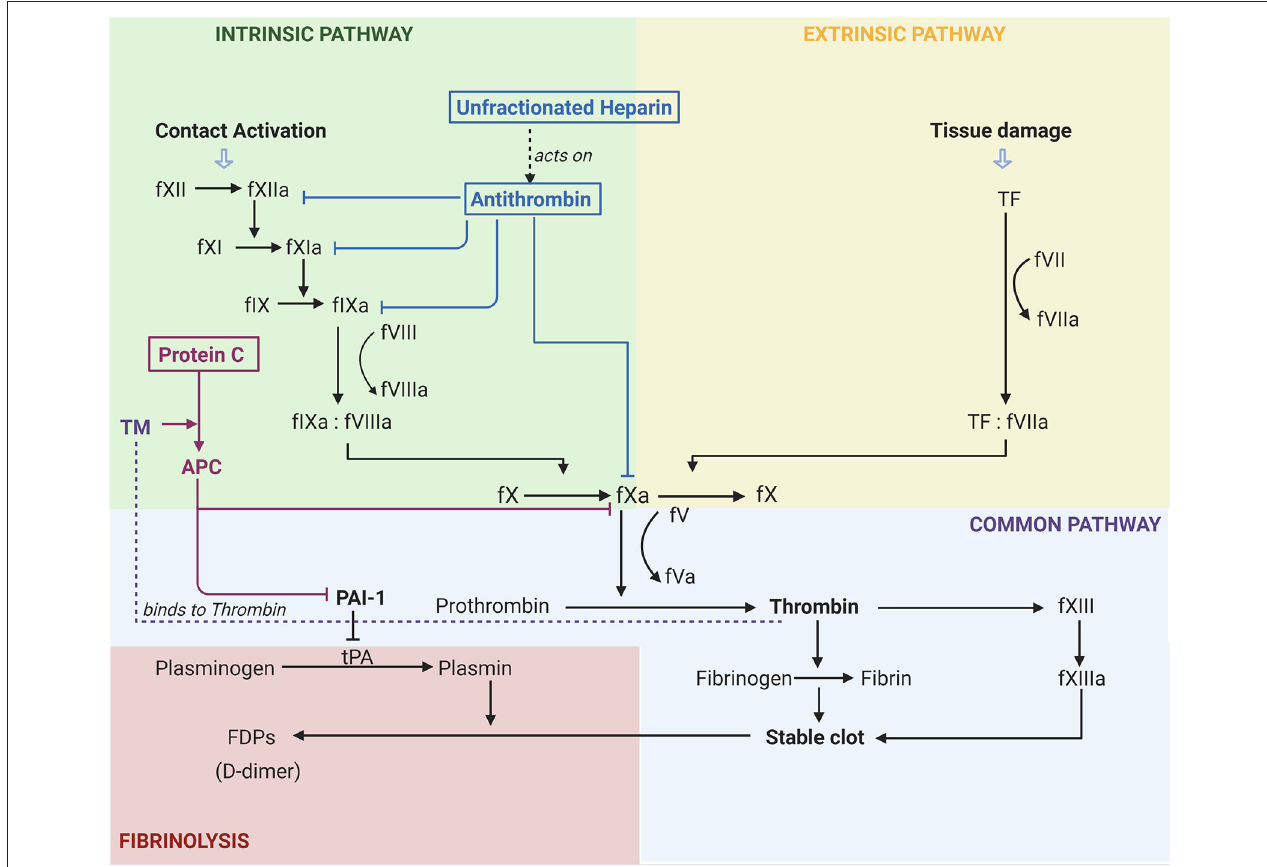
FIGURE 1 | Activation of coagulation pathways and the effects of common anticoagulants in Acute Respiratory Distress Syndrome. F(number)a, factor, “a” indicates active; TF, tissue factor; FDP, Fibrinogen Degradation Product; tPA, Tissue Plasminogen Activator; PAI-1, Plasminogen Activator Inhibitor 1; TM, Thromobomodulin; APC, Activated Protein C. The activation of the extrinsic pathway (yellow) occurs due to tissue damage, whilst the activation of the intrinsic pathway (green) occurs with contact activation. Both of these lead to the common coagulation pathway (purple) and ultimately the fibrinolytic pathway (red). It can be seen that unfractionated heparin acts on antithrombin to inhibit coagulation factors XII, XI, IX, and X. Thrombomodulin is essential for the activation of protein C, and the subsequent inhibition of PAI-1. Figure created with